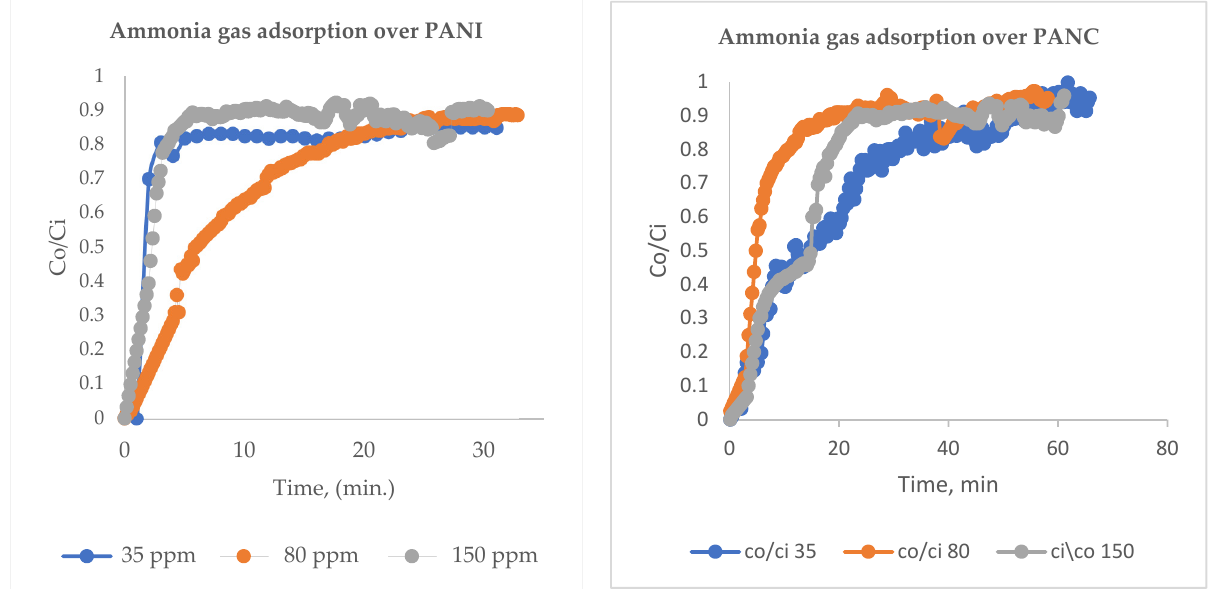
Figure 5. Breakthrough curves for NH 3 removal over PANI and PANC at different inlet gas concen- trations (35–150 ppm). Table 2. Adsorption capacity of NH 3 over PANI and PANC at different inlet gas